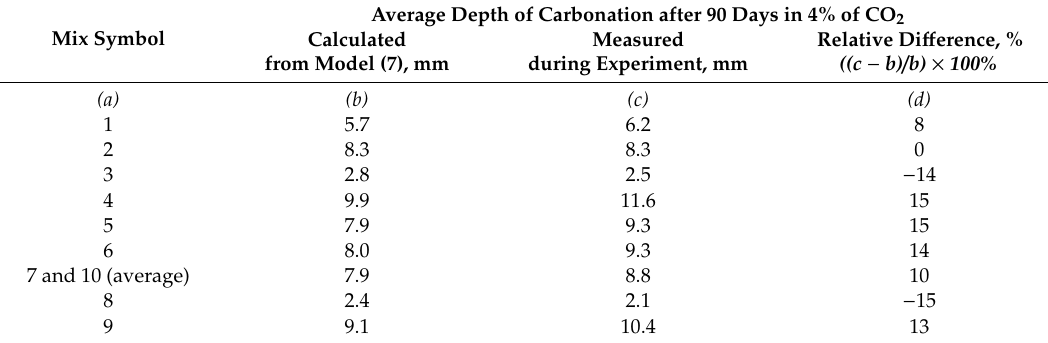
Table 9. Comparison of experimental and calculated values of depth of carbonation.